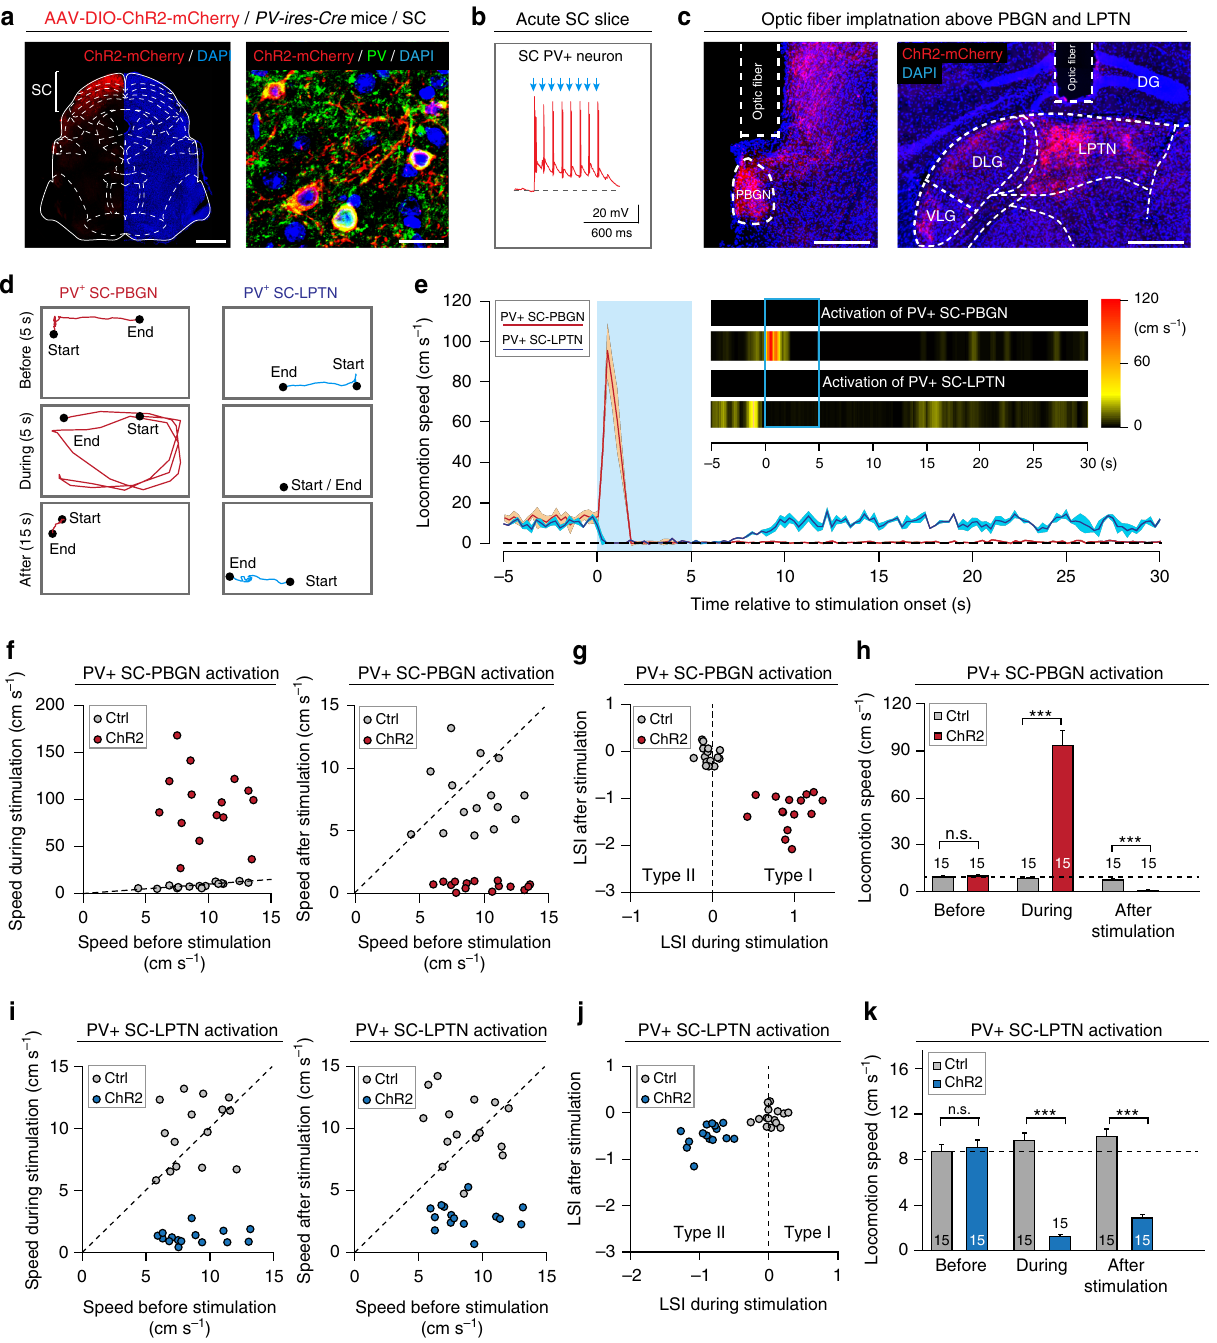
Fig. 5 Activation of PV + SC-LPTN pathway and PV + SC-PBGN pathway mimicked dimorphic defensive behavioral patterns. a Coronal section (left) and micrograph (right) showing speci fi c expression of ChR2-mCherry in SC PV + neurons after AAV-DIO-ChR2-mCherry injection. Scale bars, 1 mm (left) and 20 μ m (right). For single-channel micrographs and quantitative analyses, see Supplementary Fig. 6b. b A light-pulse train (473 nm, 10 Hz, 1 ms, 8 pulses, 20 mW) reliably triggered APs from ChR2-mCherry + neurons in the acute SC slices. c Example micrographs showing optic fi ber tracks above the ChR2- mCherry + axon terminals in the PBGN (left) and LPTN (right). Scale bars, 0.3 mm. d Locomotion trails of example mice in home-cages before, during, and after optogenetic activation (10 Hz, 20 ms, 5 s, 20 mW) of PV + SC-PBGN and PV + SC-LPTN pathways. e Averaged time course of locomotion speed before, during, and after activation of the PV + SC-PBGN (red, n = 15 mice) and PV + SC-LPTN (blue, n = 15 mice) pathways. Cloudy area indicates SEM of the averaged data. Inset, heat-maps of locomotion speed of example mice. f , i Distributions of locomotion speed during vs. before (left) and after vs. before (right) optogenetic activation of the PV + SC-PBGN ( f ) and PV + SC-LPTN pathways ( i ). g , j Distribution of LSI during stimulation and LSI after stimulation of mice with (ChR2) or without (Ctrl) activation of the PV + SC-PBGN ( g ) or SC-LPTN ( j ) pathways. h , k Quantitative analyses of locomotion speed before, during, and after optogenetic activation of the PV + SC-PBGN ( h ) and SC-LPTN ( k ) pathways. For the analyses of PV + SC-LDTN pathway, see Supplementary Fig. 6f and g. Data in ( h , k ) are means ± SEM (error bars). Numbers of mice are indicated in the bars. Statistical analysis was Student ’ s t test (*** P < 0.001; n.s. P >